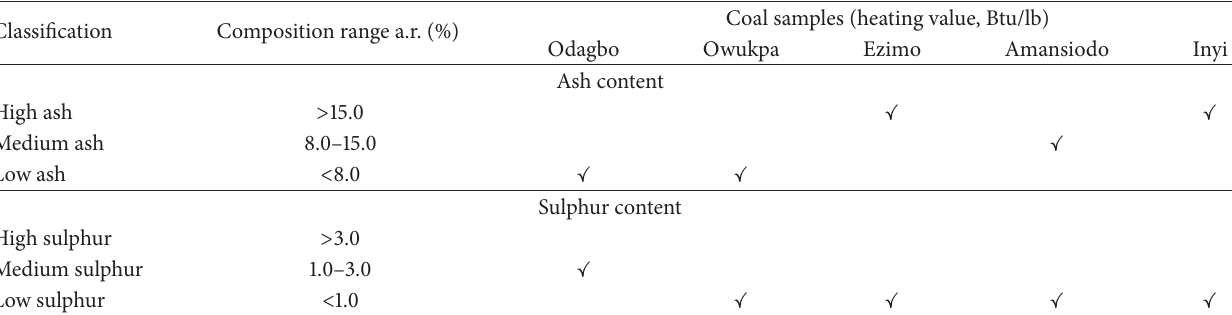
Table 9: Ash and sulphur classification of the five coal